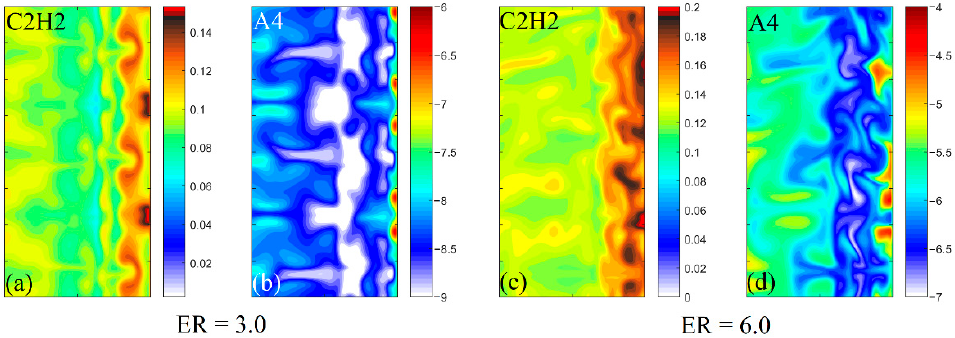
Figure 12. Mass concentration distribution of acetylene (C 2 H 2 ) and pyrene (A4) at different equivalence ratios after detonation impacts the wall for 0.2 µs. ( a ) acetylene at ER = 3.0; ( b ) pyrene at ER = 3.0; ( c ) acetylene at ER = 6.0; ( d ) pyrene at ER = 6.0.